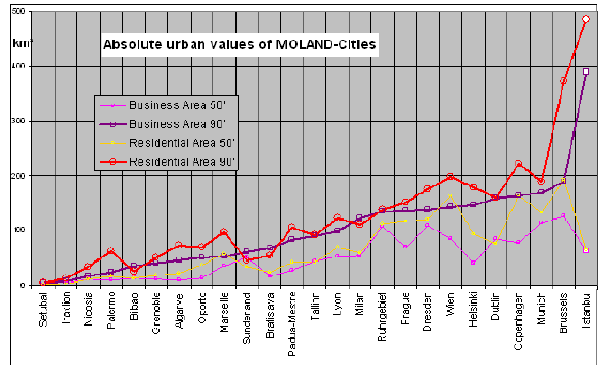
Figure 11: absolute values within the last 50 years.